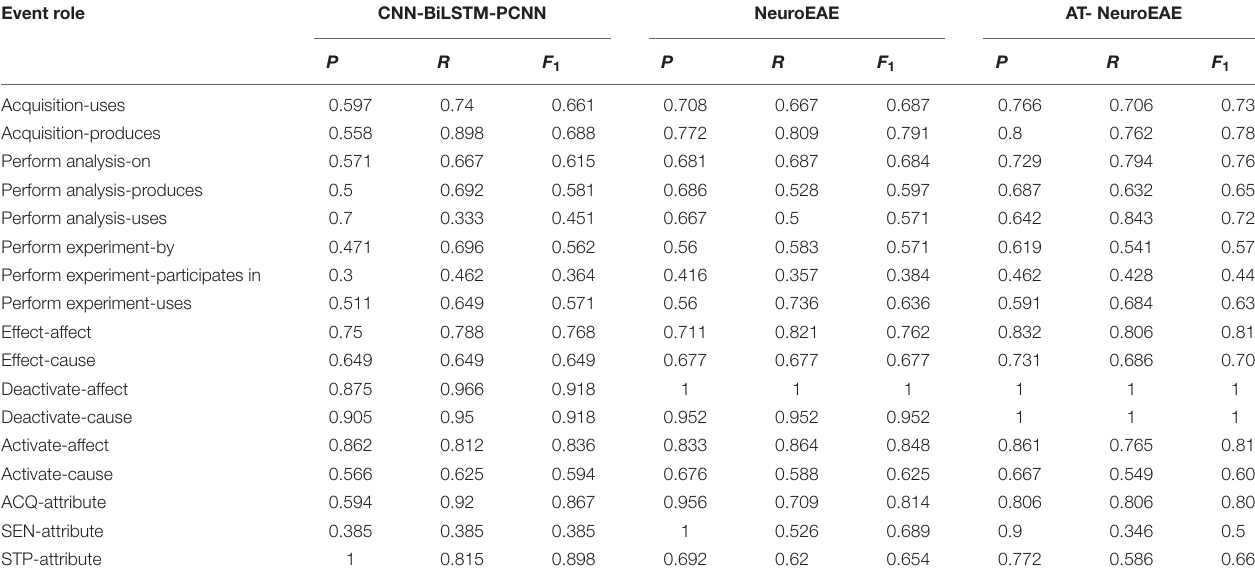
TABLE 10 | Role-attribute recognition.